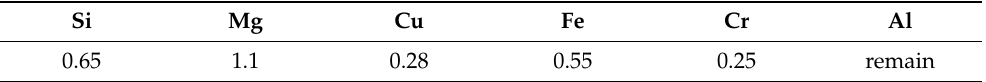
Table 1. Chemical composition of the base matrix aluminum alloy,